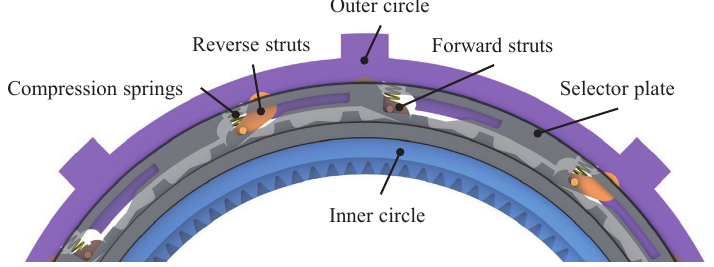
Figure 5. Schematic diagram of the first and reverse